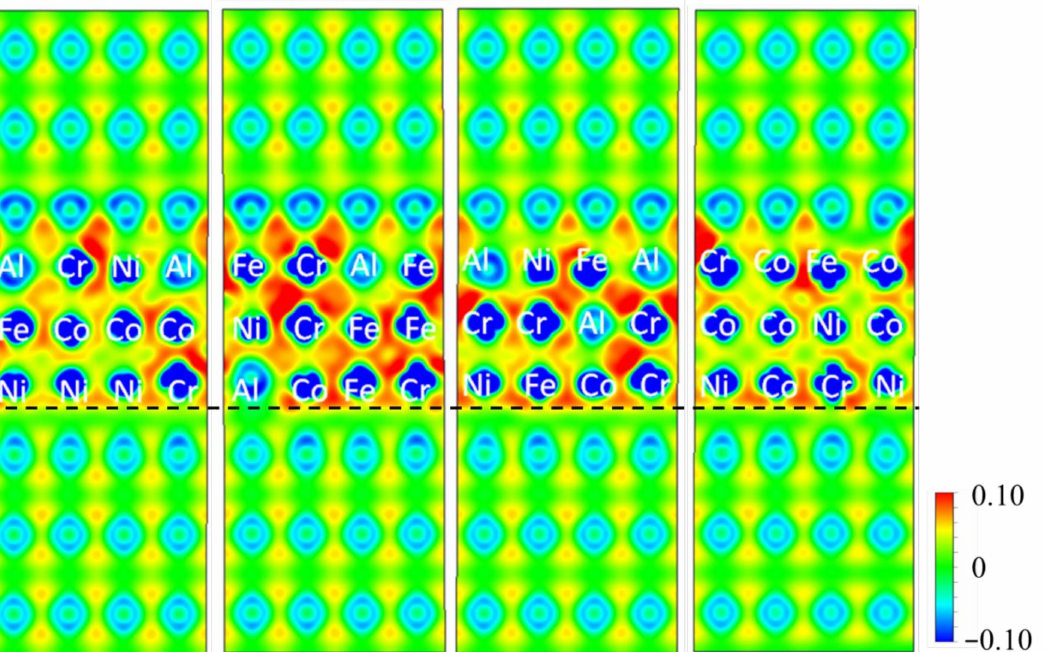
Figure 4. Four slices of isosurface plots of differential charge density ∆ ρ within the plane perpendicu- lar to the (001) Al